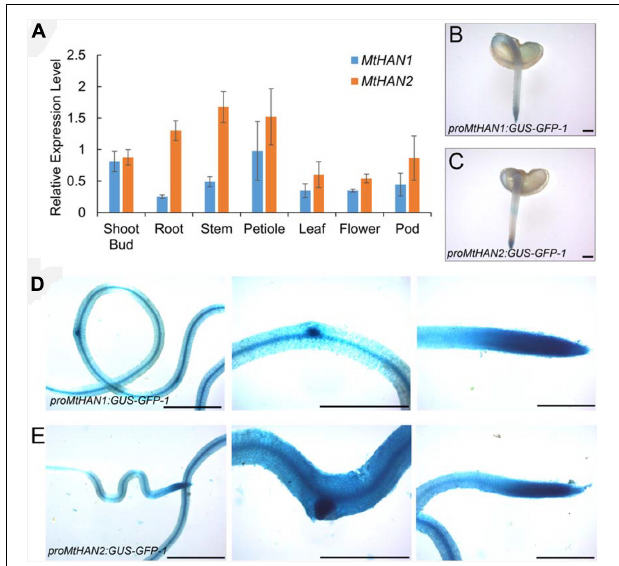
FIGURE 3 | Expression patterns of MtHAN1 and MtHAN2 . (A) The expression patterns of MtHAN1 and MtHAN2 in tissues of shoot bud, root, stem, petiole, leaf, flower, and pod. (B–E) GUS expression in roots that were transformed with either proMtHAN1:GUS–GFP in panel (B,D) or proMtHAN2:GUS–GFP in panel (C,E) . (B,C) GUS staining in 5-days-old germinating seeds. (D,E) GUS staining in root vascular, lateral root primordial, and main root tip of 7-days-old root. Bars = 1